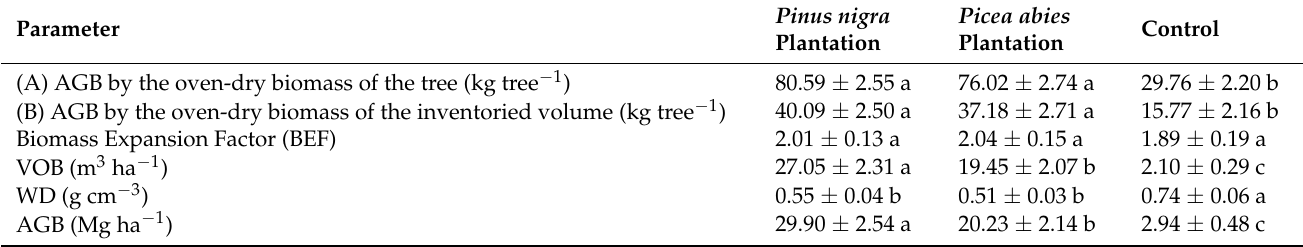
Table 7. The above-ground biomass (AGB) of trees (mean ± SD) estimated by the FAO model in the study